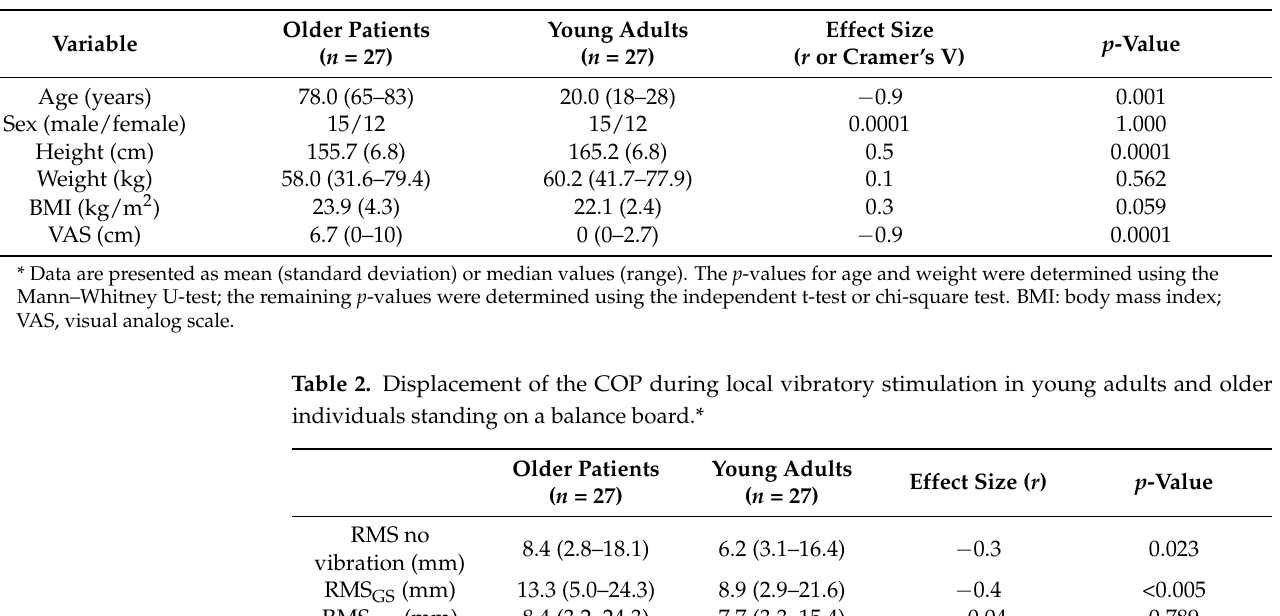
Table 1. Participant characteristics.*